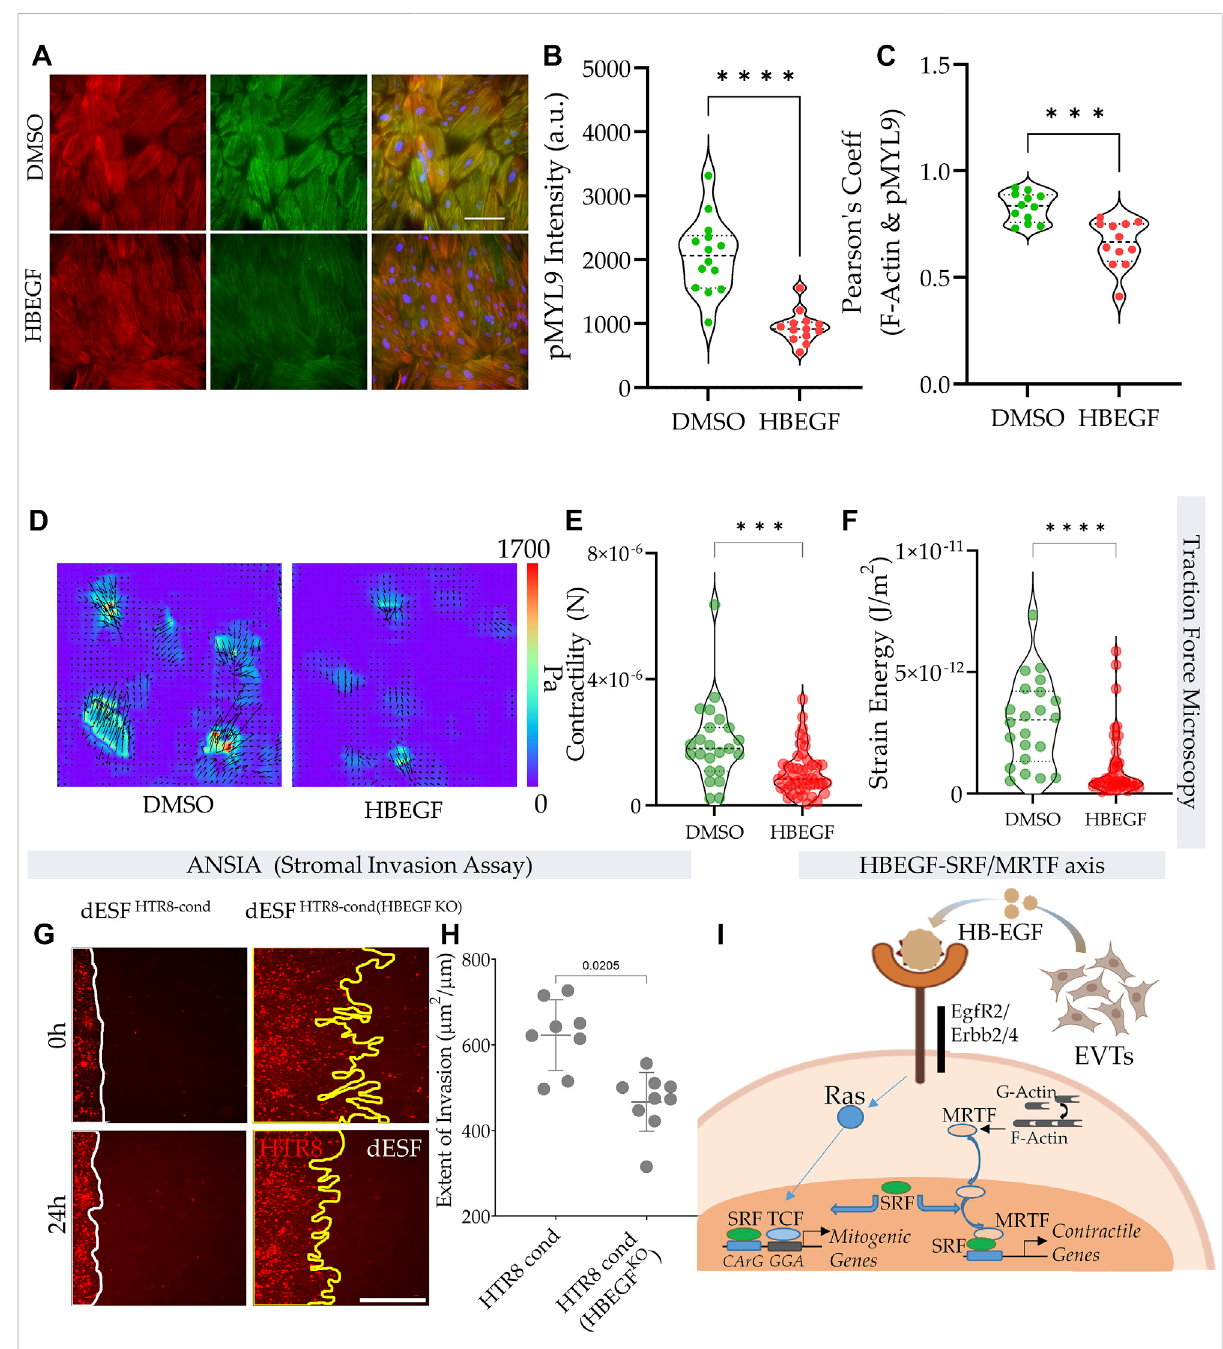
FIGURE 6 HB-EGF from EVTs reduce contractile force generation in dESFs reducing decidual resistance to invasion. (A) Immuno fl uorescence images of dESFs treated with DMSO control, and HB-EGF (HBEGF) showing F-actin, phospho-MYL9, and combined expression; scale bar = 25 mm. (B – C) Average intensity per cell for phospho-MYL9, and Pearson ’ s coef fi cient showing F-actin and phospho-MYL9 colocalization. (D – F) HB-EGF reduces dESFcontractileforcegeneration. (D) StressvectorspatialmapsshowingrepresentativeexamplesofdESFstreatedwithout,orwithHB-EGFfor 24 h. Individual cell contractility shown in (E) , and strain energy density shown in (F) ; n > 20. (G – H) HB-EGF decreases dESF resistance to HTR8 invasion. (G) Representative images of HTR8-dESF interface at time 0 and 24 h shown for dESFs pre-treated with conditioned medium from wild-typeHTR8,orfromHTR8withgenesilencingforHB-EGF. (H) Quanti fi cationoftheextentofstromalinvasionbyHTR8forconditionsinj; n > 10. (I) Schematic showing the balance of SRF transcriptional association with either TCF co-factors acting through CaRG response element, or with MRTF-A/B co-factors present in nucleus upon release by polymerized actin in the